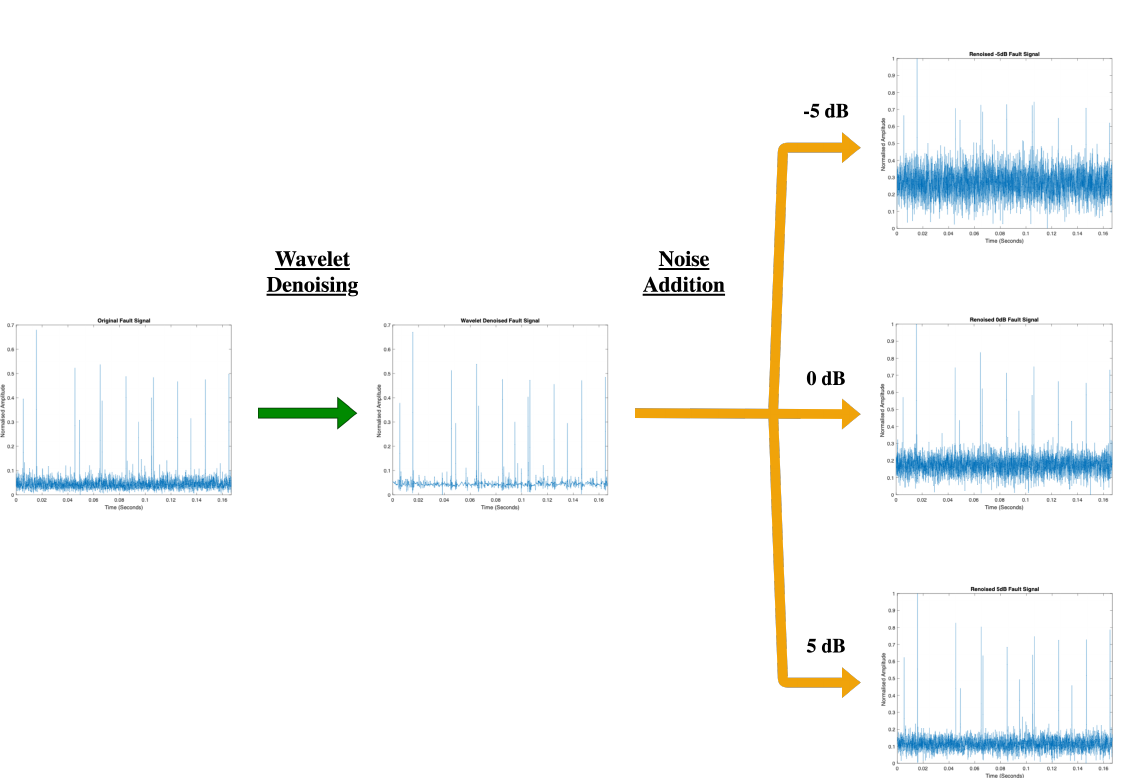
Figure 9. Flow diagram picturing the steps taken to create datasets with varying known noise